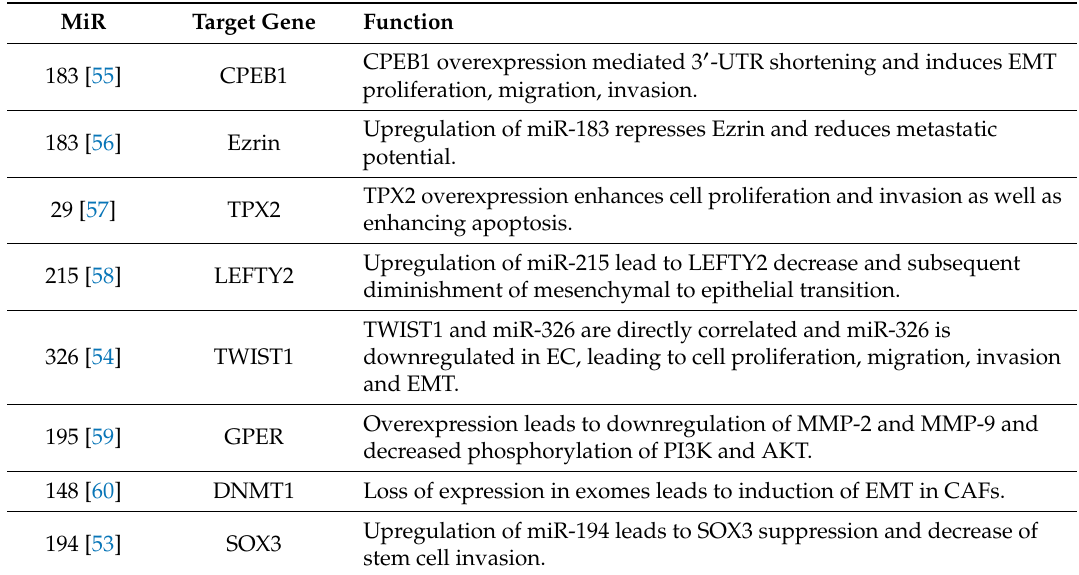
Table 2. MicroRNAs connected to epithelial to mesenchymal transition in endometrial cancer